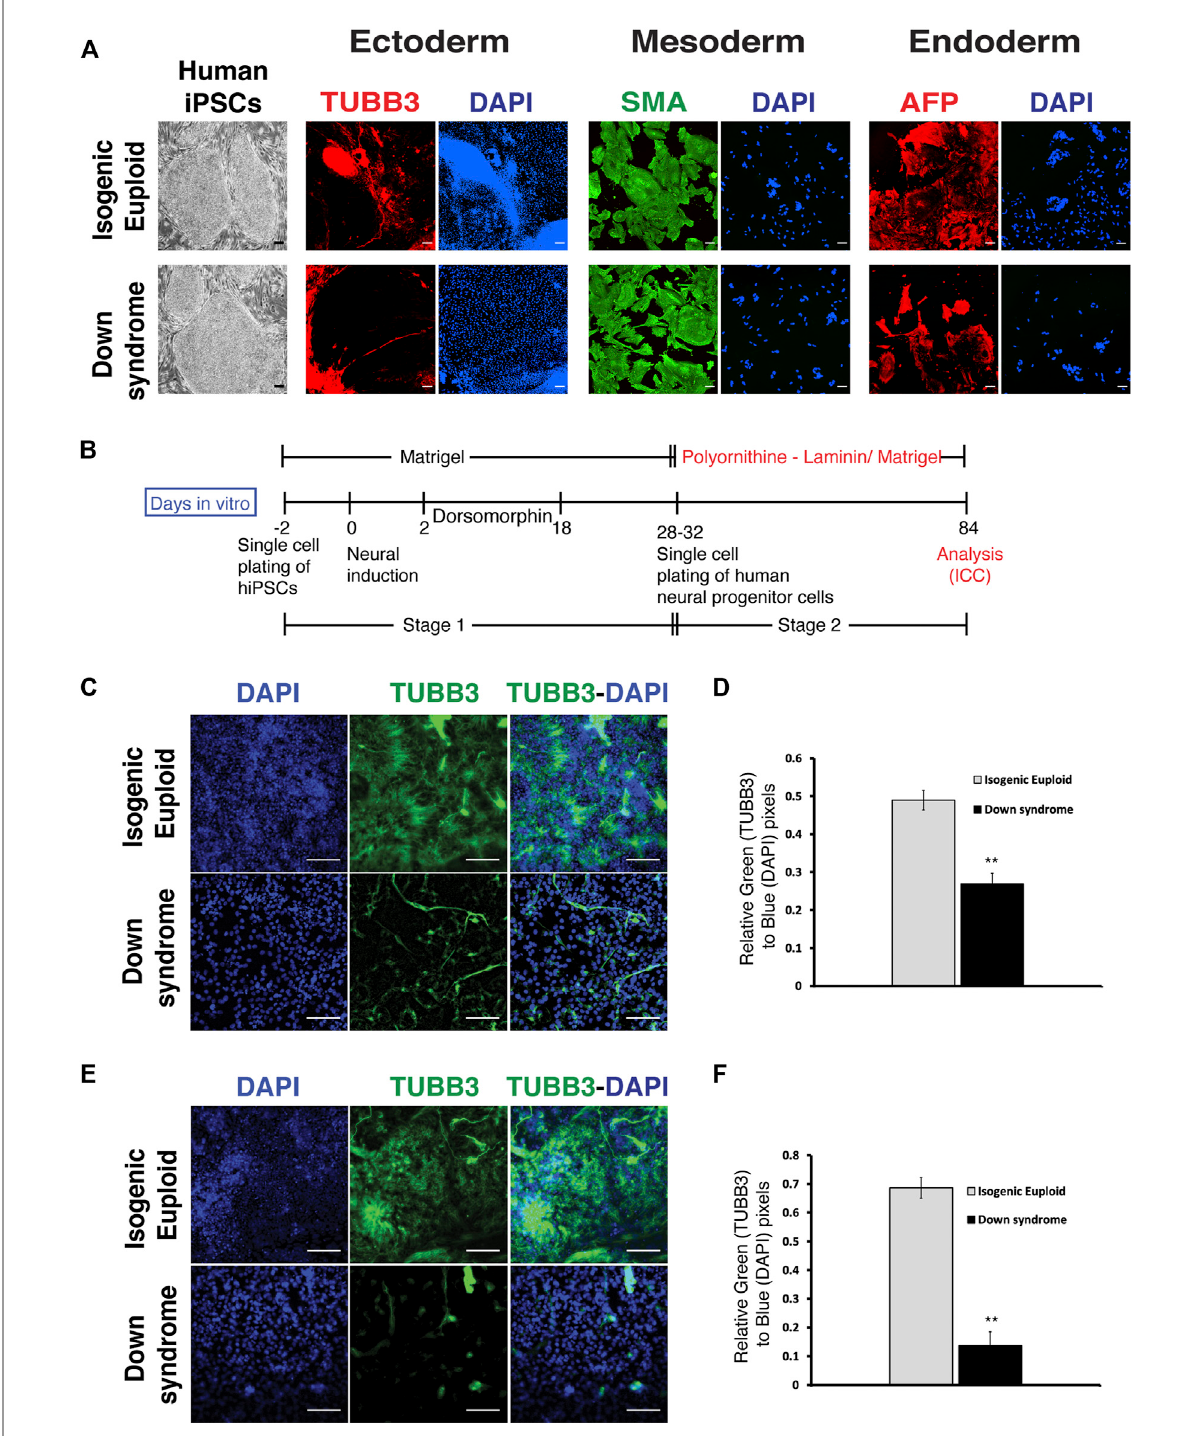
FIGURE 4 Monolayer-mediated differentiation of Down syndrome human iPSCs display reduced neural differentiation. (A) Representative images of Down syndrome human iPSCs (hiPSCs), its isogenic euploid hiPSCs, and three germ layer differentiation. Three germ layer analysis was done using ICC for Tubulin beta 3 (TUBB3) (red) for ectoderm, Smooth muscle actin (SMA) (green) for mesoderm, and Alpha fetal protein (AFP) (red) for endoderm. Corresponding DAPI (blue) staining for each image has been shown. Scalebar is 100 μ M. (B) Schematics of neural differentiation protocol of hiPSCs on poly Ornithine-Laminin or Matrigel. Stage 1 is de fi ned as the differentiation of iPSCs to neural progenitors, and stage 2 is de fi ned as the differentiation of neural progenitors to postmitotic neural differentiation. (C) Representative images of TUBB3 (green) expressing